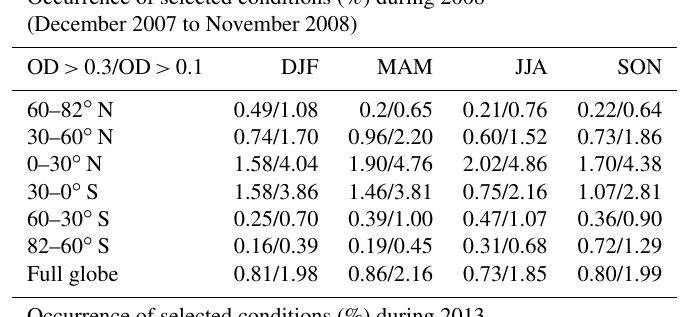
Table 4. Sampled cirrus cloud frequency of occurrence for each 30 ◦ latitude zone, and also for the entire globe (last line) during 2008 and 2013. Two lower OD thresholds were used; OD > 0.3 and OD > 0.1 (separated by a